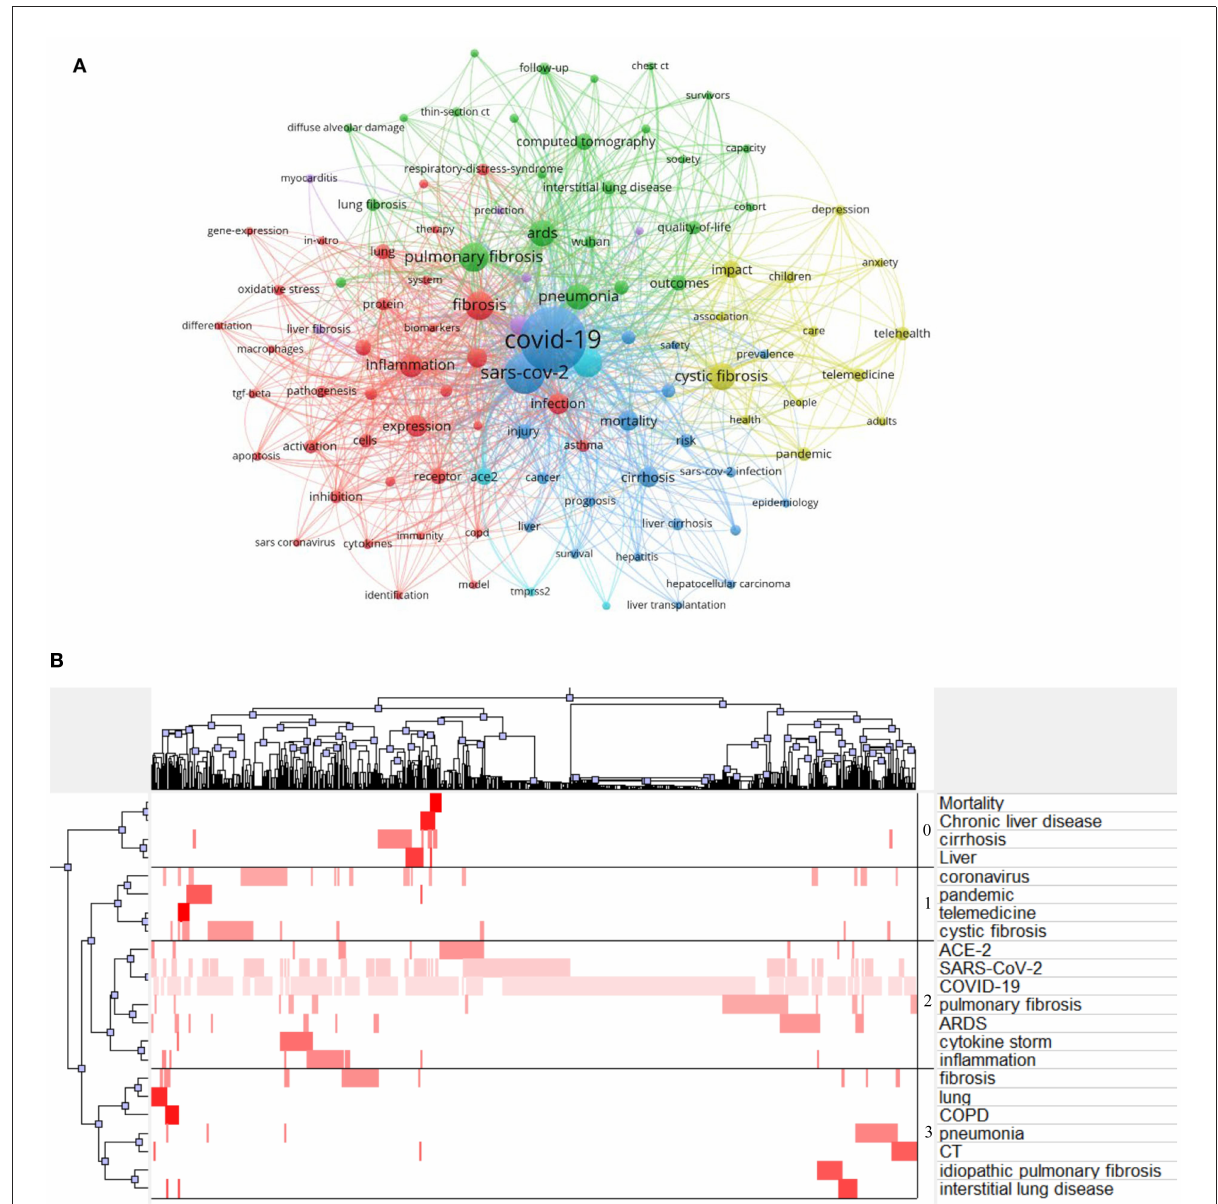
FIGURE1 Topmost keywords. (A) A network of most frequent keywords was generated by VOSviewer, different colors classified clusters, bubble size indicated publication amount, and thickness of the line revealed linkage strength between keywords. (B) Bi-clustering matrix was generated by Graphical Clustering Toolkit, X -axis indicated the sequence number of publications, and Y -axis represented high-frequency keywords. The tree indicated connections between publications or high-frequency keywords. The darker color of the red blocks revealed a higher appearance of high-frequency keywords in a particular